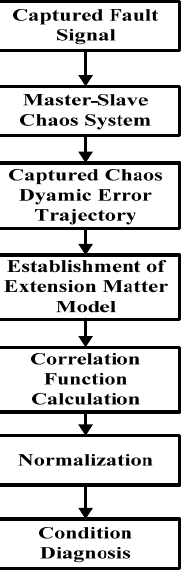
Figure 6. Flowchart of the master-slave chaos dynamic error